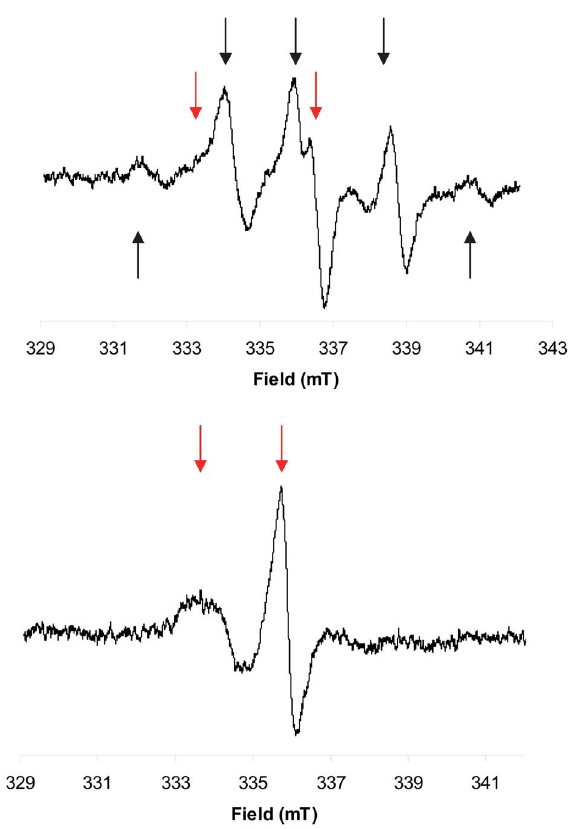
Figure 6. EPR signal observed in X-band for the GrandioSo composite, 1 month after polymerization (top) and 3 months after polymerization (bottom). Black arrows show lines of the documented EPR spectrum of resins. Red arrows show lines from the atypical component of the spectrum.